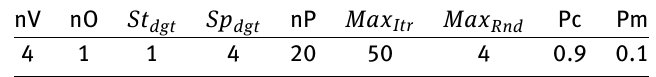
Table 21: VSSCGA Settings for Himmelblau’s function with 4 variables